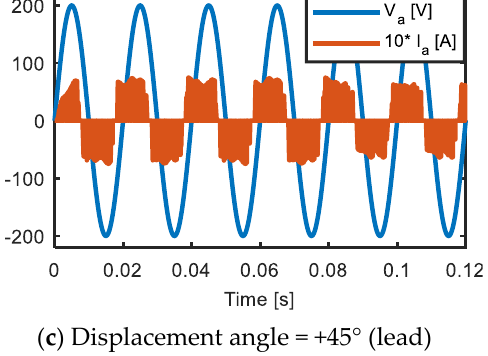
Figure 8. Simulation results for control of the input displacement factor.